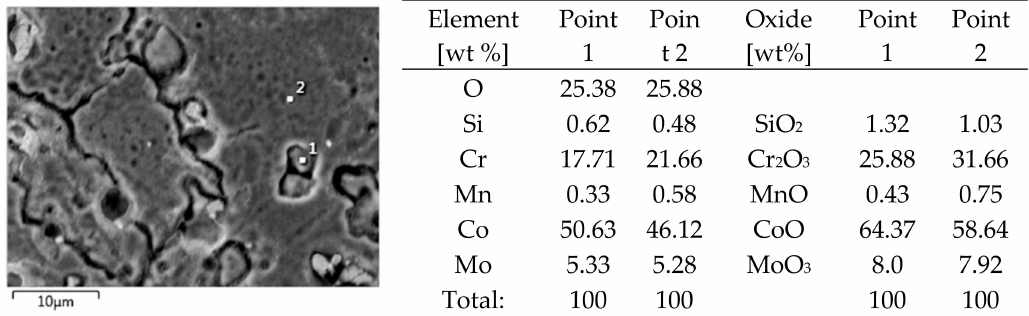
Figure 12. Results of EDS point analyses for MSM sample after corrosion